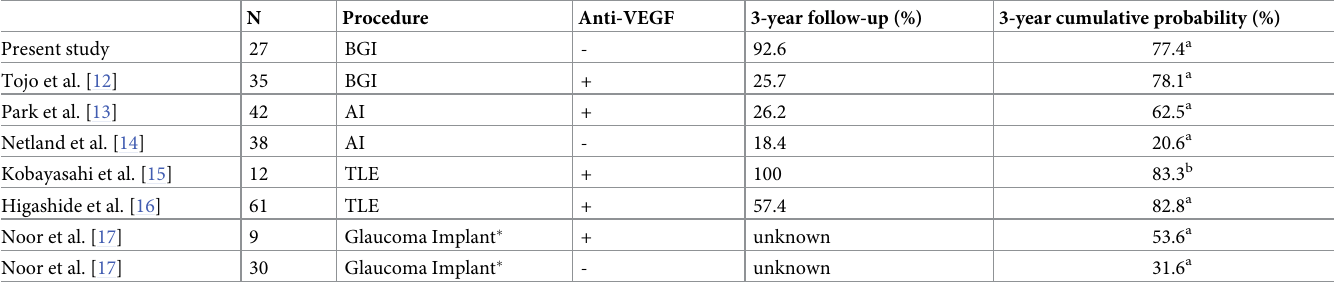
21%; vitreous hemorrhage, 16%; endophthalmitis, 3.4%; and retinal detachment, 4.5%, in BGI surgery with vitrectomy. In tube shunt surgery for NVG, the incidence rates of vitreous hem- orrhage and hyphema seem high. In this study, the incidence rates of vitreous hemorrhage and hyphema were 18.8% and 18.8%, respectively (Table 3). On the other hand, no complications Table 4. Surgical success of 3-year follow-up in neovascular glaucoma.